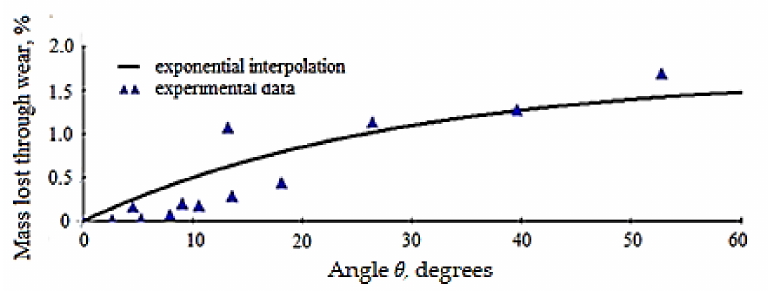
Figure 8. Interpolation function variation (6) for the material mass lost due to wear ( m w ) from the active side of the dental milling cutter.